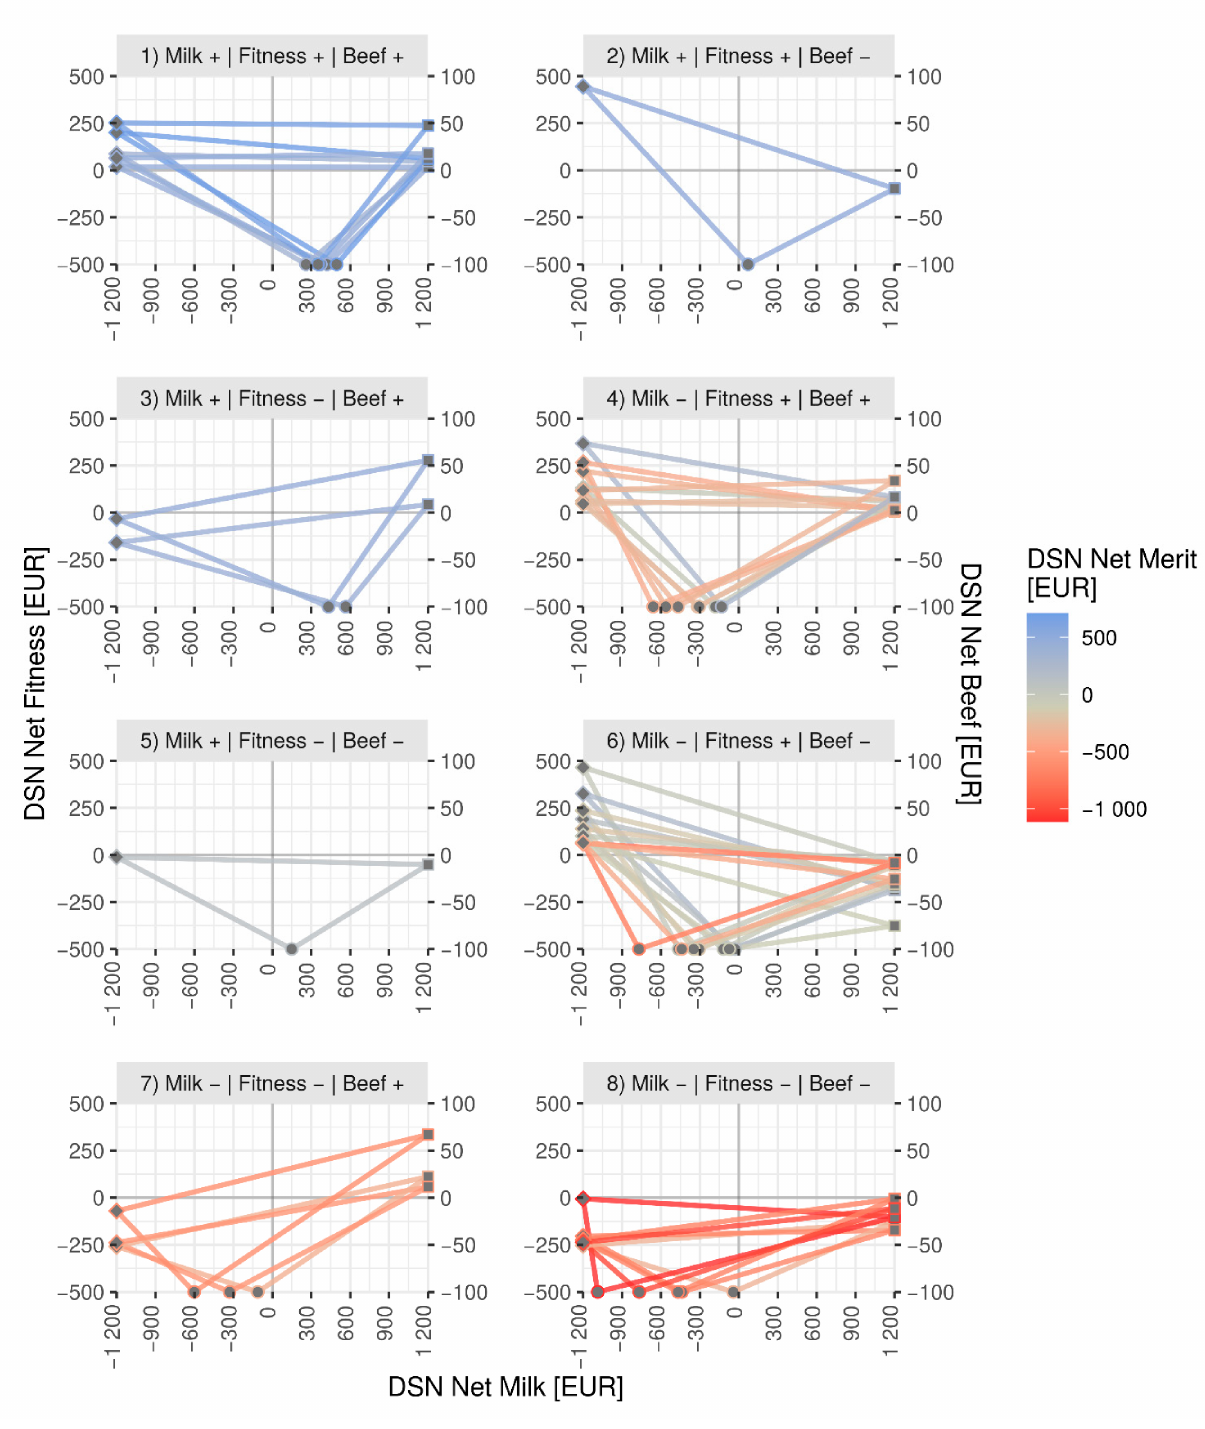
Figure 1. Patterns for 33 DSN sires based on the sub-indices of DSN Net Merit. Each sire is represented by a triangle connecting DSN Net Milk (dots on x -axis), DSN Net Fitness (rotated quadrats on left y -axis), and DSN Net Beef (squares on right y -axis) in Euro. The color of a triangle depends on the DSN Net Merit of the sire (blue most positive, red most negative). The sires were grouped by their combination of positive (+) and/or negative ( − )